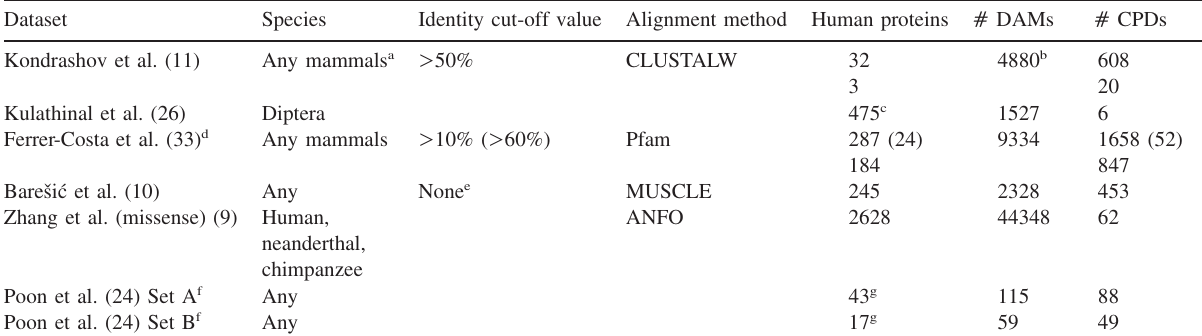
Table 1 Datasets of compensated pathogenic deviations described in the literature. Dataset Identity cut-off value Alignment method Human proteins (cid:2)